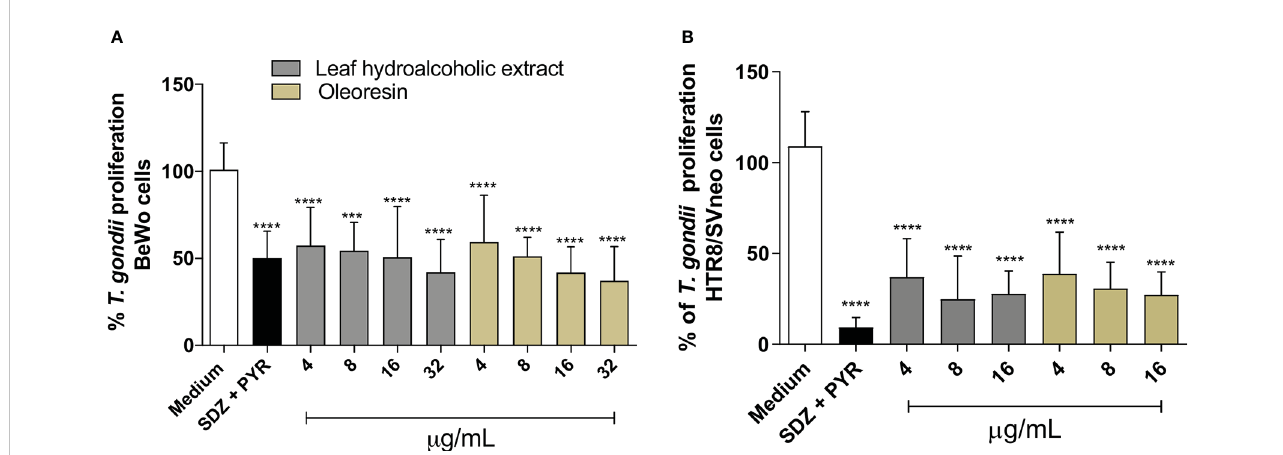
FIGURE 2 T. gondii intracellular proliferation. BeWo (A) and HTR8/SVneo (B) cells were infected by T. gondii and treated or not with non-toxic concentrations of hydroalcoholic extract or oleoresin from C. multijuga for 24 h. Untreated and infected cells (medium) were considered as 100% parasite proliferation, and SDZ + PYR was used as positive control. T. gondii intracellular proliferation was analyzed using a b -galactosidase colorimetric assay and expressed as percentage (% of T. gondii proliferation) in comparison to untreated cells (medium). The results were expressed as means ± standard deviation of three experiments performed in eight replicates. Signi fi cant differences detected by One-Way ANOVA, Bonferroni ’ s multiple comparisons post-test. *** P < 0.0001 or **** P < 0.00001 in relation to the